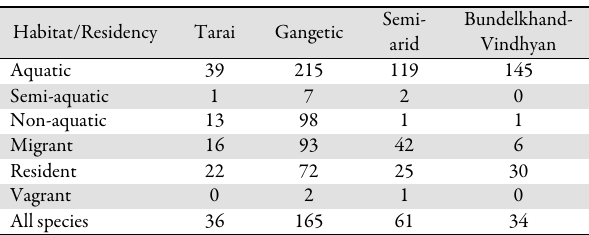
Table 6. Density of individuals (ha -1 ) by habitat and residency of bird species